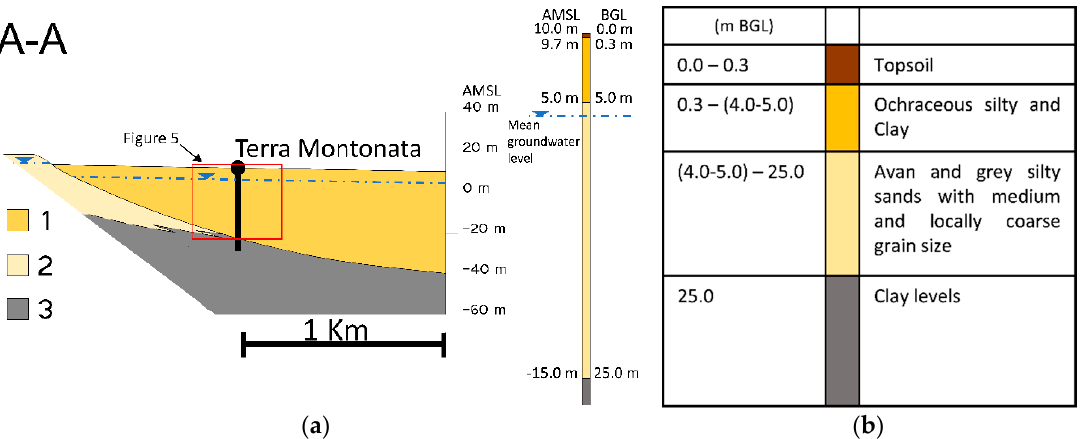
Figure 2. ( a ) Geological cross-section in interfluve area. (1) Coastal plain deposits; (2) terrace deposits; (3) sub-Apennines clays; ( b ) detail of stratigraphy detected close to Terra Montonata monitoring station (not to scale).